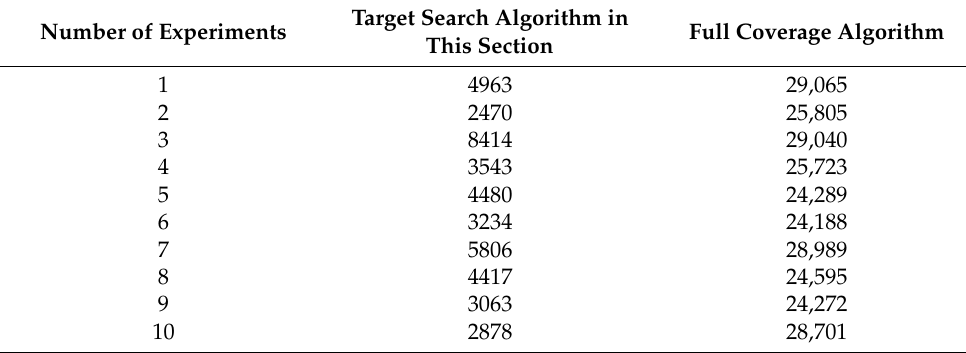
Table 3. Comparison of the number of steps used to search for all targets.